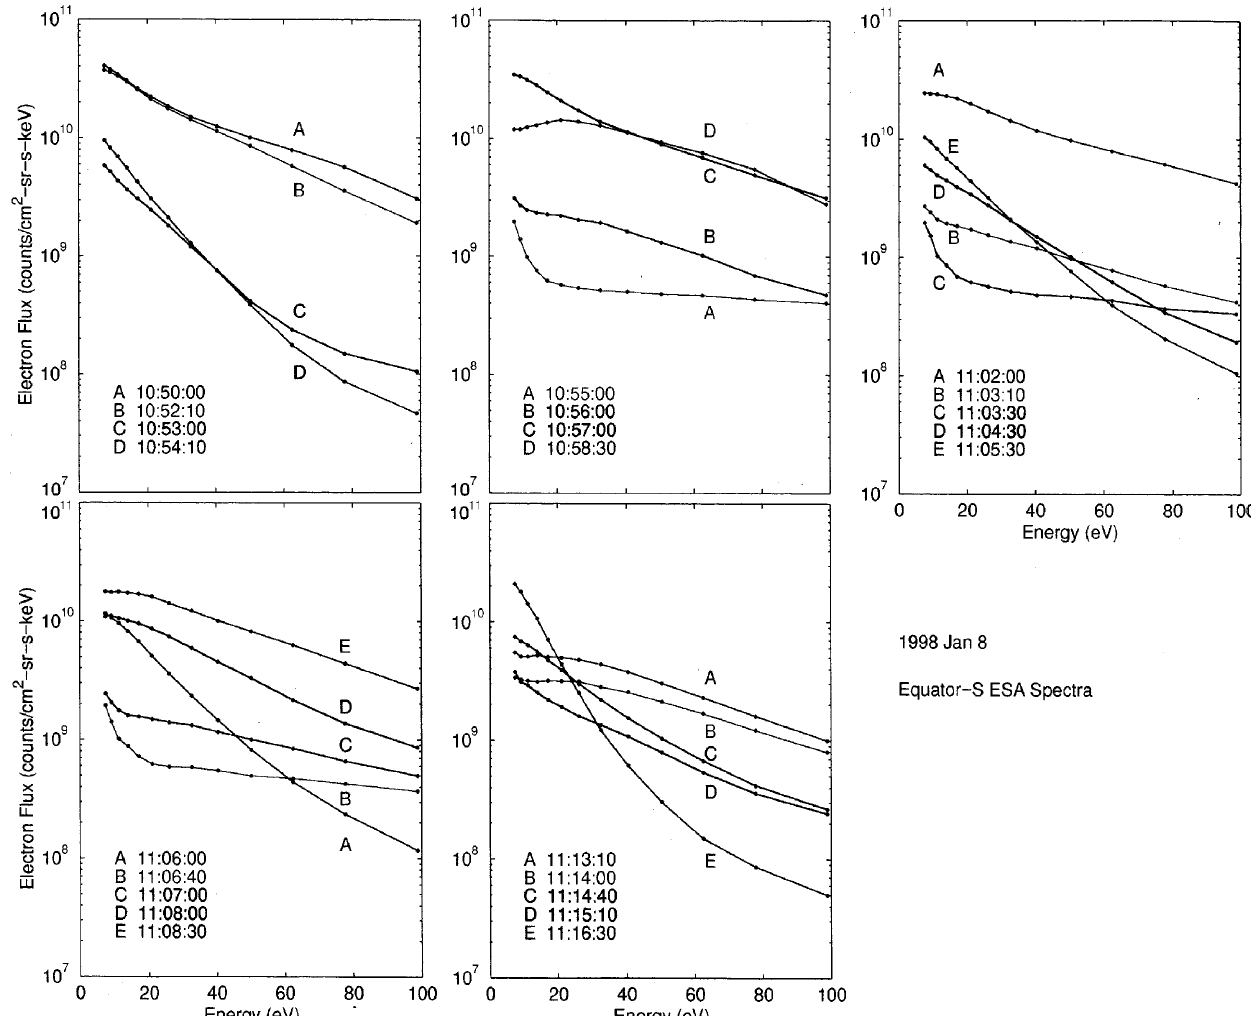
Fig. 5. Energy spectra of (cid:25) 7 eV–100 eV electrons for selected regions. See Fig. 3 for corresponding flux-time